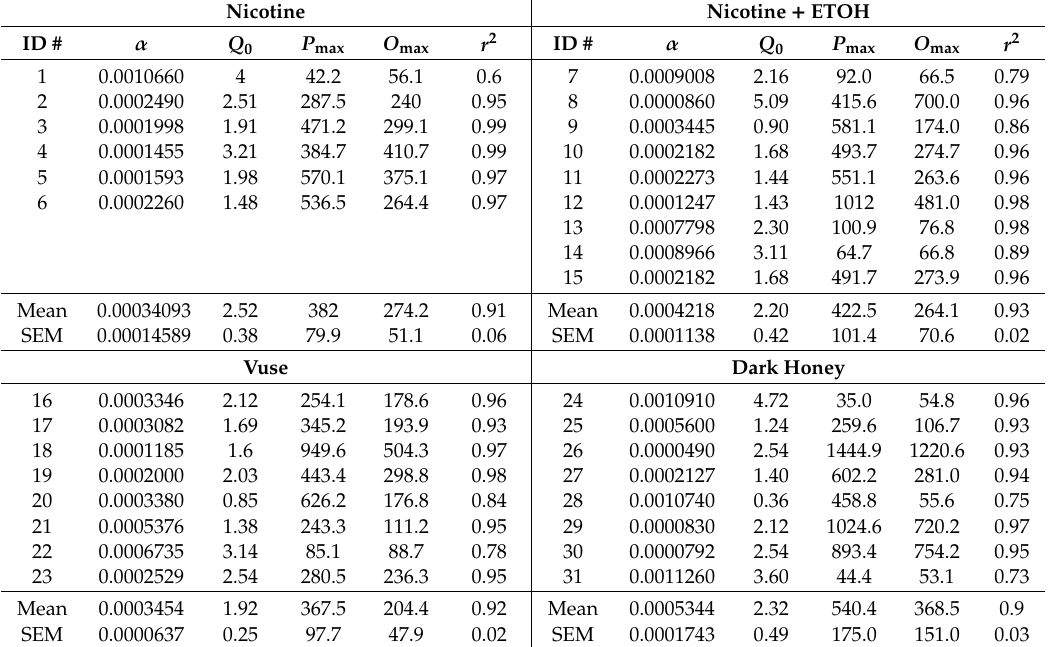
Figure 2. Group demand curves for each formulation in the subsets of rats that acquired self-administration and completed FR escalation ( N = 6–8 per formulation). Table 1. Individual exponential demand curve parameters across formulations ( k = 2.907).